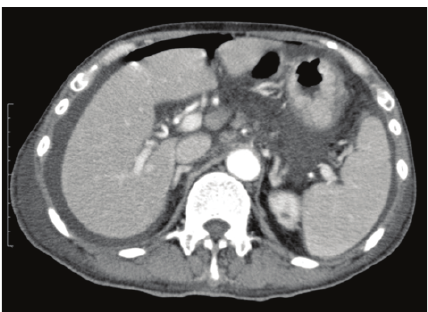
Figure1:Detectionoffreeairinthepatientwiththyroidstorm,a55- year-old Japanese male. Contrast-enhanced abdominal CT shows the presence of free air in the surface of the liver associated with